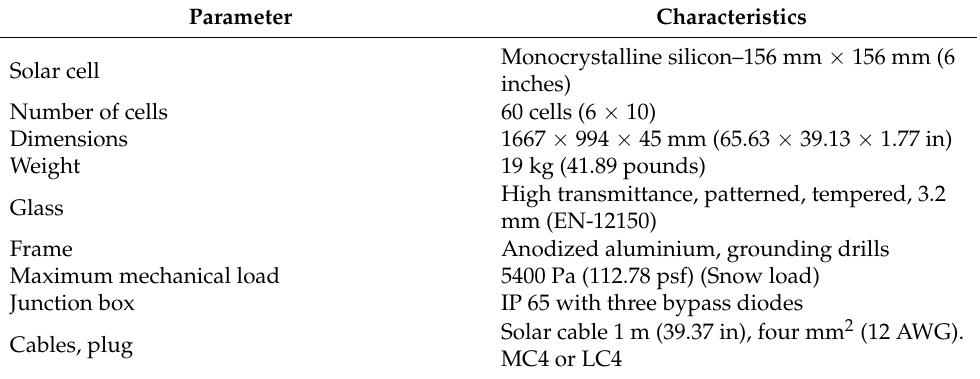
Table 5. Electrical characteristics of the monocrystalline Module ISF-250 [40]. Performance at STC: Irradiance, 1000 W/m 2 ; cell temperature, 25 °C (77 °F); AM, 1.5. Parameter